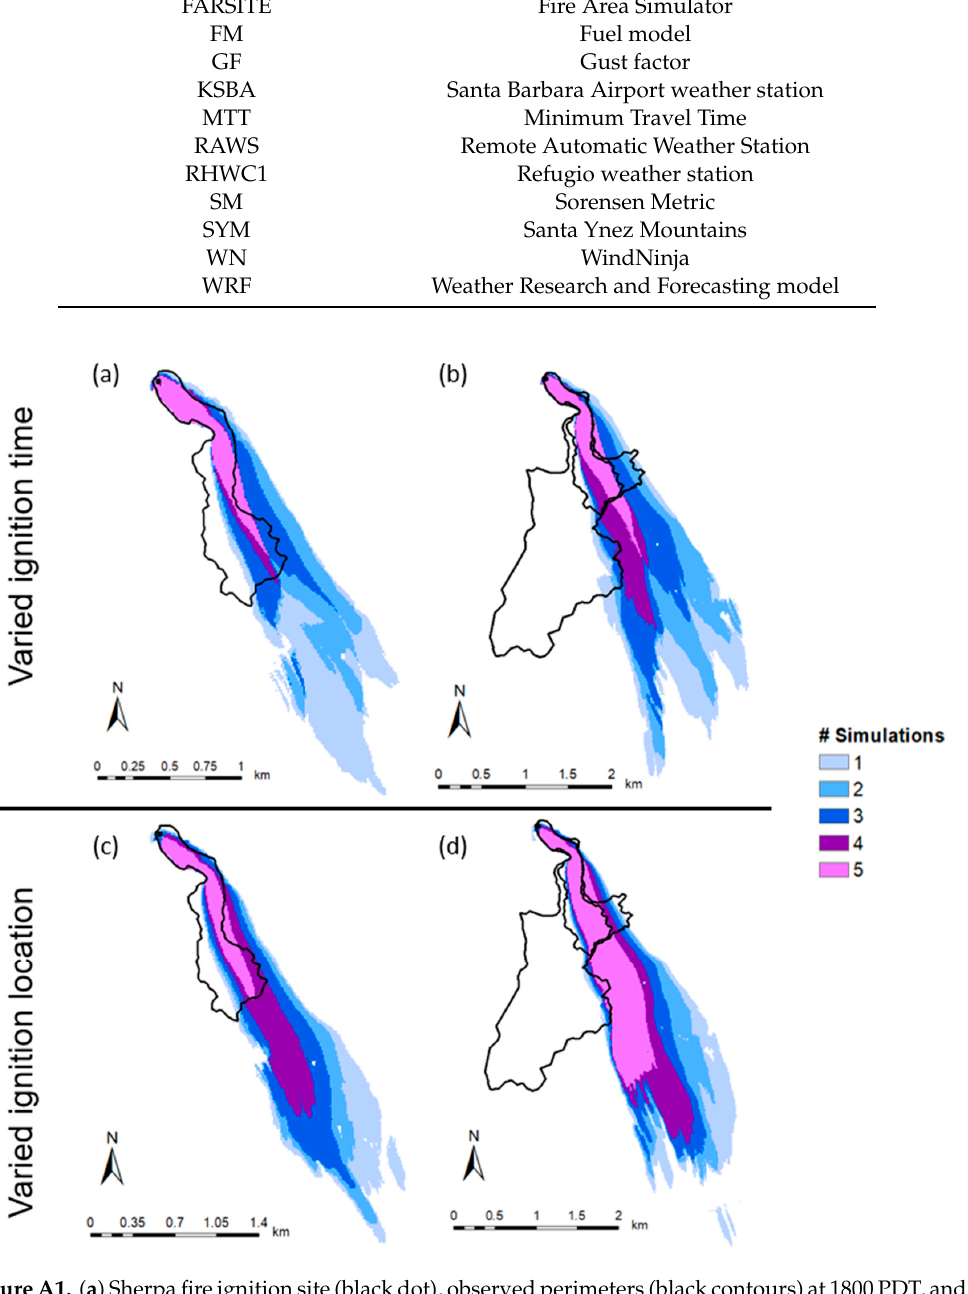
Figure A1. ( a ) Sherpa fire ignition site (black dot), observed perimeters (black contours) at 1800 PDT, and the count of overlapping simulations three hours after ignition in the varied ignition time simulations. ( b ) Same as ( a ) with the 1900 PDT observed perimeter added and the count of overlapping simulations four hours after ignition. ( c ) same as ( a ) with the count of overlapping simulations in the varied location simulations three hours after ignition. ( d ) same as ( c ) four hours after ignition.